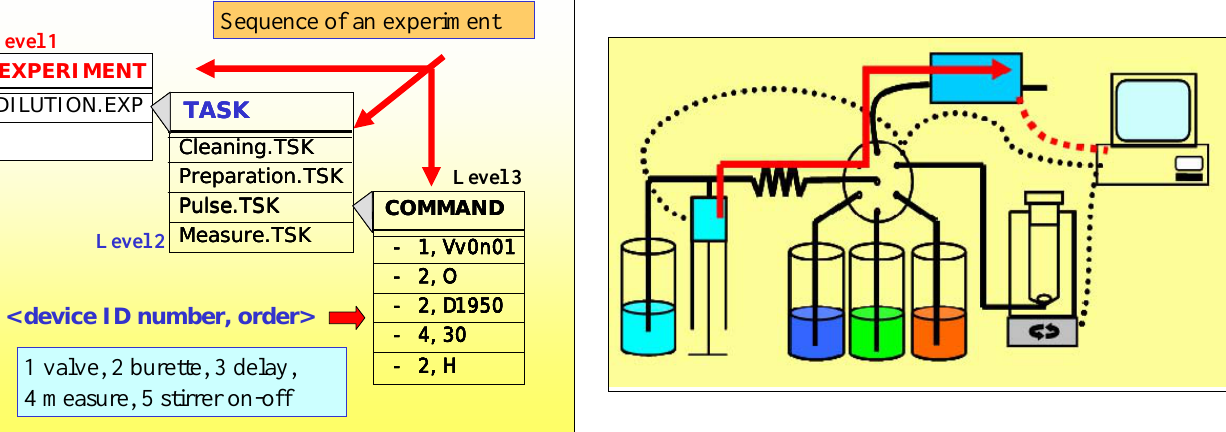
Figure 4. Illustration of the three software levels of instructions during a sequence of an